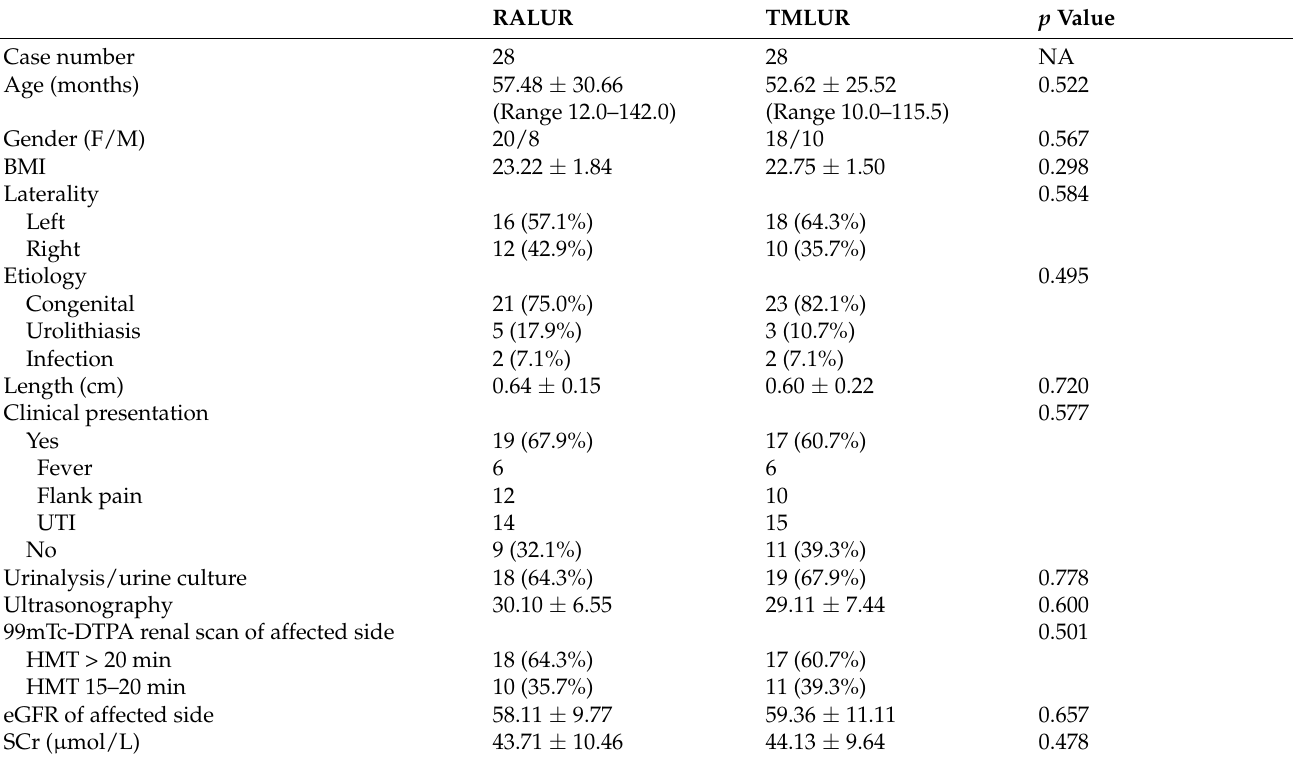
Table 1. Patient demographics and clinical features in RALUR and TMLUR